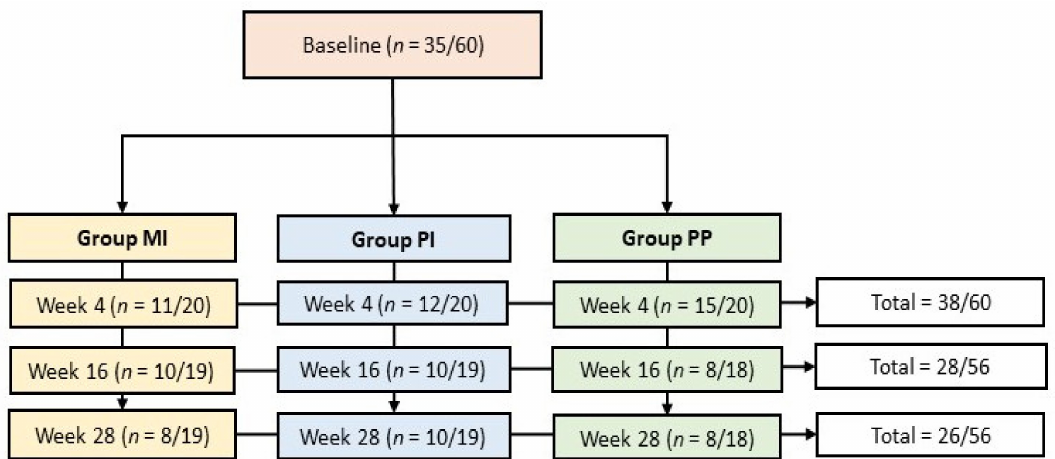
Figure A2. Flow diagram showing total stool sample collection at di ff erent time points from di ff erent groups. MI: metronidazole-inulin; PI: placebo-inulin; PP: